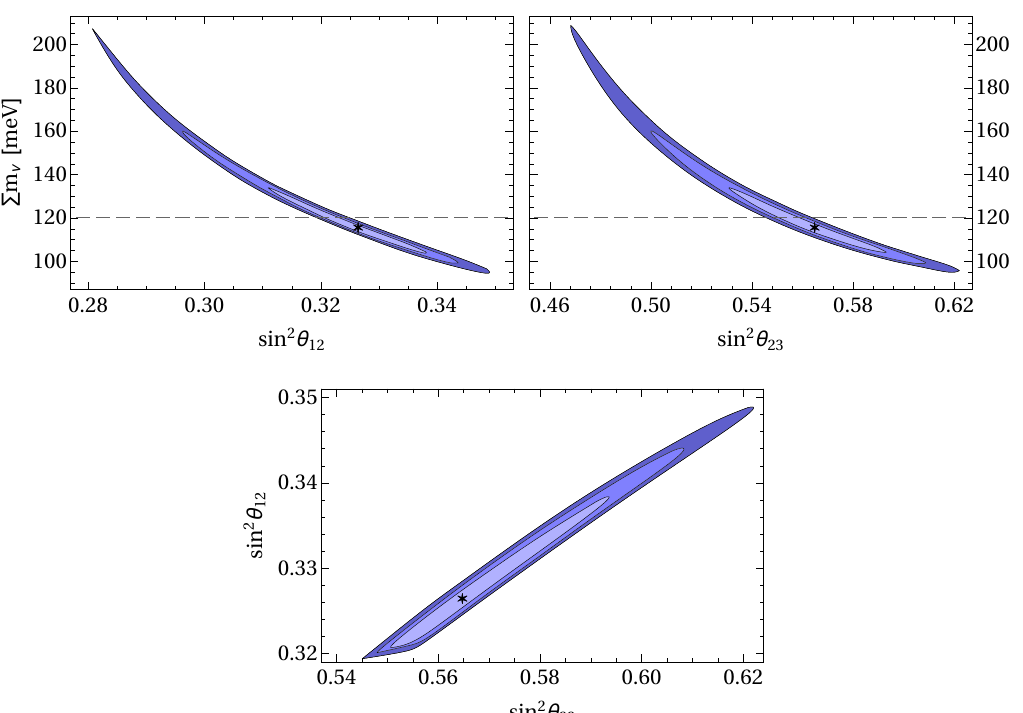
Figure 5 . The correlation among s 2 , s 2 , and the cosmological mass in a model uniting models 4 12 23 and 5 together. In the top row, the dashed line represents the cosmological bound (4.5). In the bottom row, the depicted areas all respect that